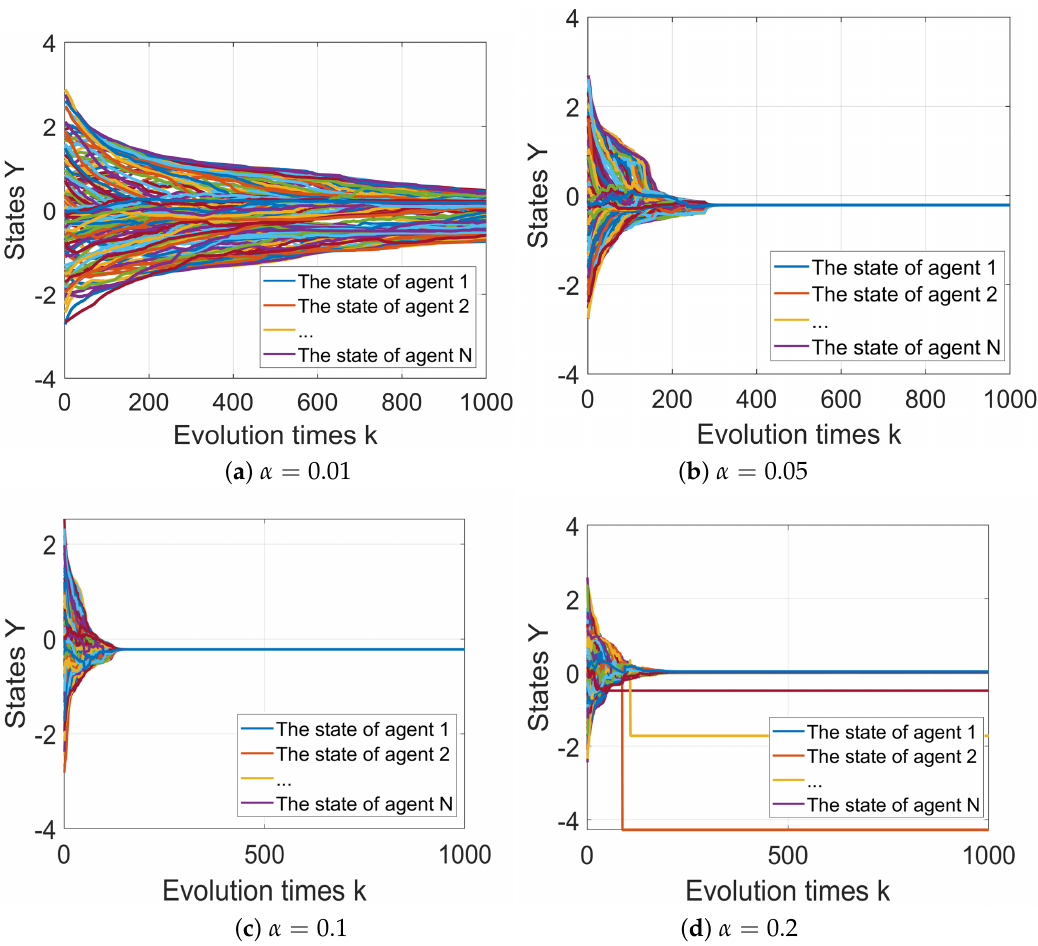
Figure 5. The evolution performance with different α